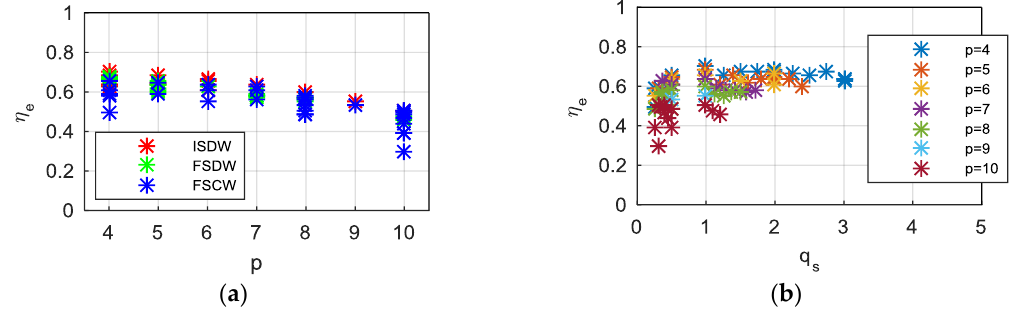
Figure 23. Electromagnetic efficiency ( η e ) versus ( a ) pole pair number ( p ) and winding type; ( b ) stator slot number per pole and phase ( q s ) and pole pair number ( p ).